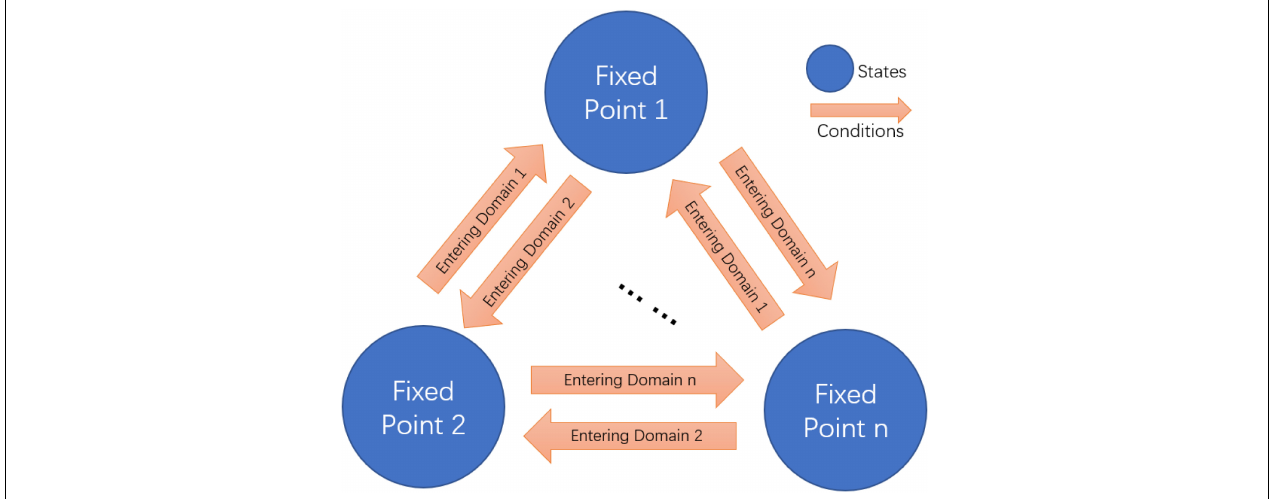
FIGURE 3 | Fixed point attractors based finite state machine.